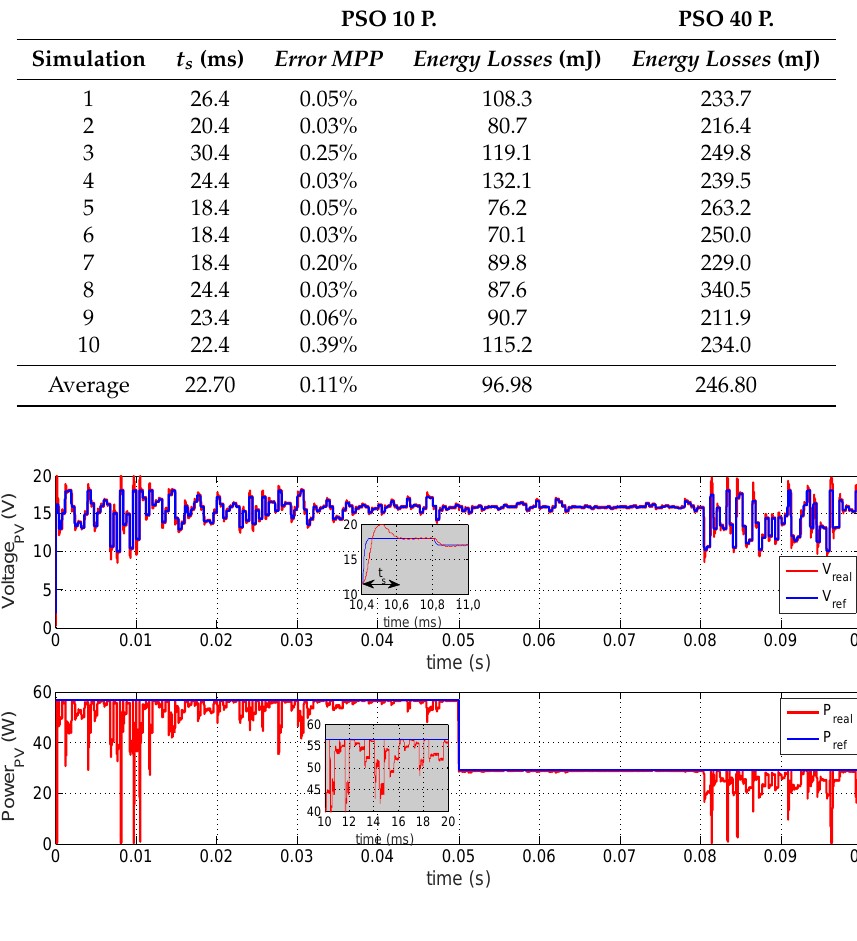
Figure 9. MPPT based in PSO with 40 particles. Profile of the PV panel voltage and power